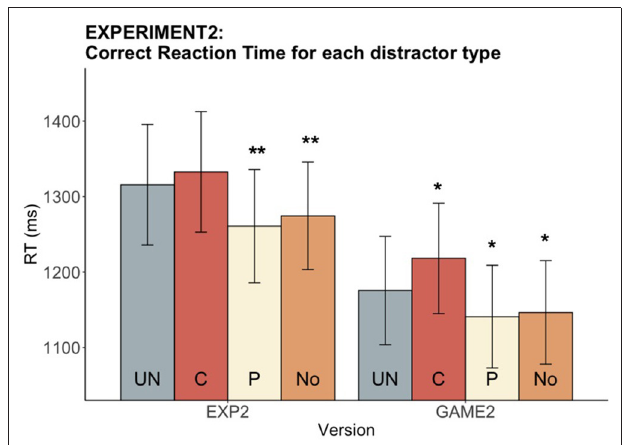
FIGURE 5 | Experiment 2: Reaction time for each distractor type in both versions. The bar chart shows mean RTs while the error bars show 95% confidence intervals. The distractor conditions are color-coded, with the UN (gray) being the baseline condition for pairwise statistical comparisons with the other three conditions. Asterisks indicate that mean RT for the corresponding condition differs significantly from the UN mean RT (* p < 0.05, ** p < 0.01).